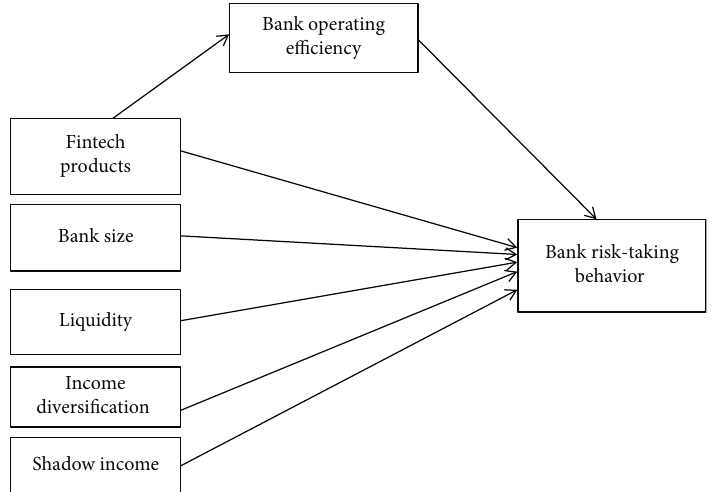
Figure 1: Theoretical framework of the